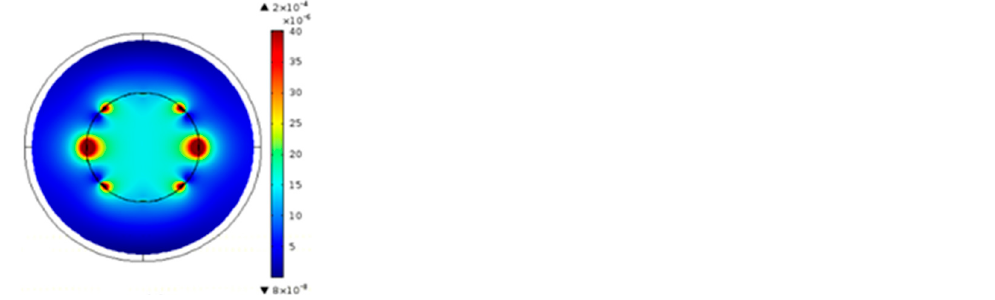
Figure 5. MRI RF magnetic field distribution in the case of the introduction of a piezoelectric with electrodes ( a ) material configuration ( b ) field distribution with electrodes perpendicular to the field ( c ) field distribution with electrodes parallel to the field [45]. The last example of EMC Monitoring in MRI, illustrates a methodology for analyzing and controlling possible disturbances in image-guided interventions or implants.